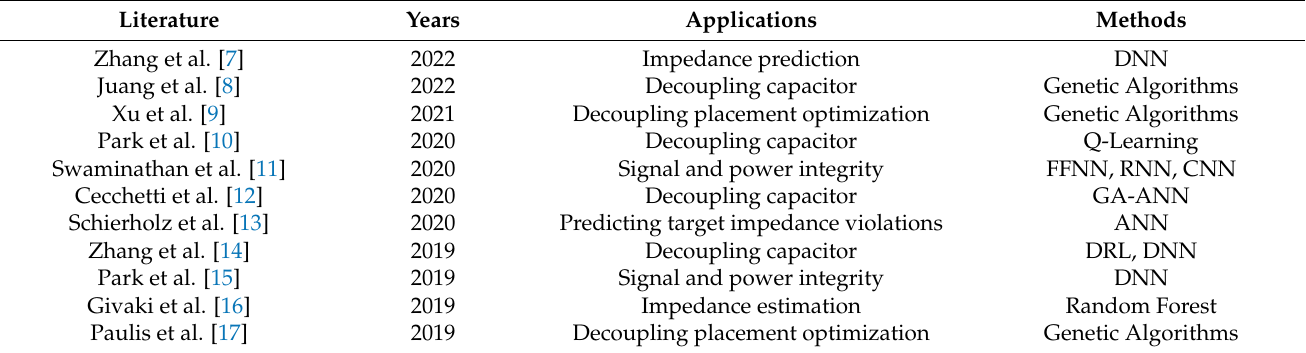
Table 1. Recent applications of machine learning approaches in circuit design and